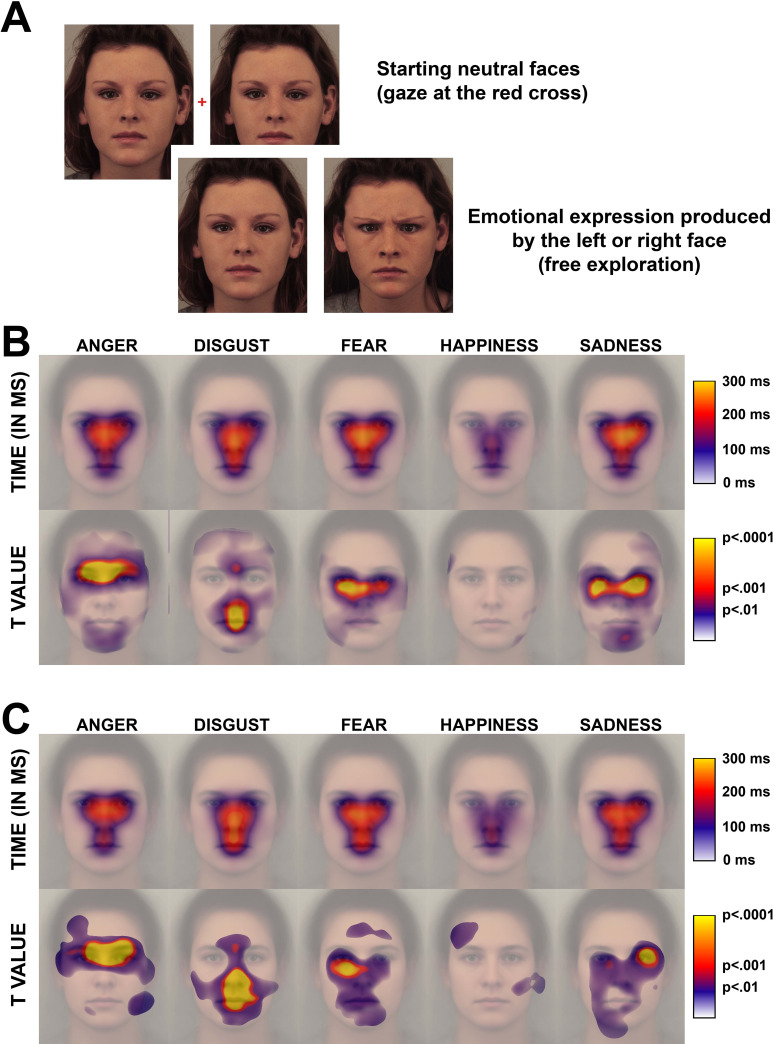
A) Illustration of the procedure. Each trial started with the neutral face of a model displayed on each side of a red cross (with the example of the KDEF model F09). Participants were instructed to look at the red cross. After a 1-sec fixation, one of the two faces was replaced by an expressive face, simulating the occurrence of an expression. B) Mean time and T values for the 5-choice task (illustrated on the prototypical face). For Time, the color code of a pixel indicates the average time the pixel was in the participants’ foveal zone. For T values, the color code indicates the p value after a Student’s T-test that compared the mean time for the emotion to the mean time for the four other emotions. Only increased time is reported. C) Mean time and T values for the Yes/No task, with the same rationale as in B.